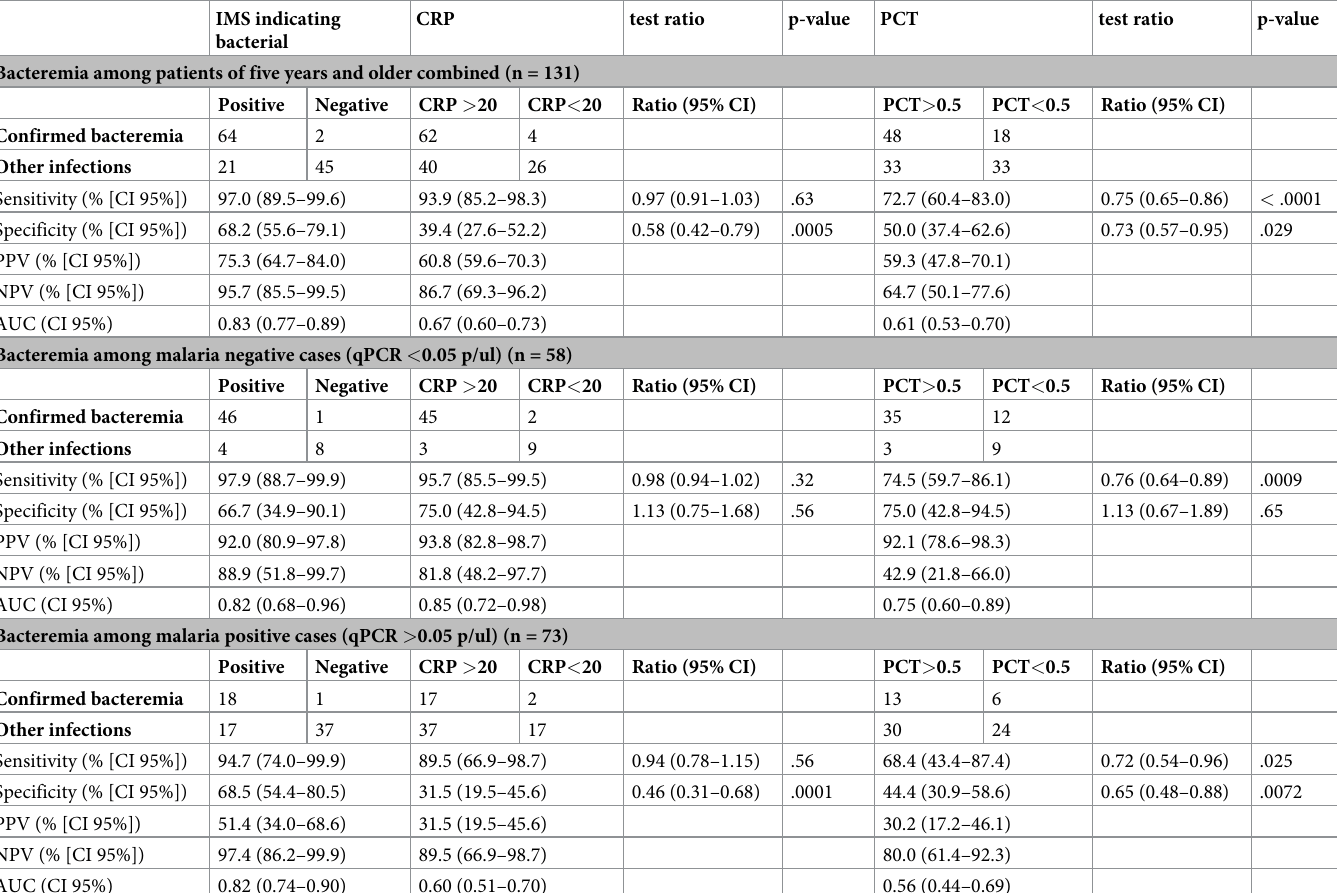
Table 6. Diagnostic accuracy of the IMS to detect bacteremia versus standard microbiological techniques among patients of 5 years and older. Data are separately presented for malaria positive cases, malaria negative cases and all cases, and compared to accuracy of CRP and